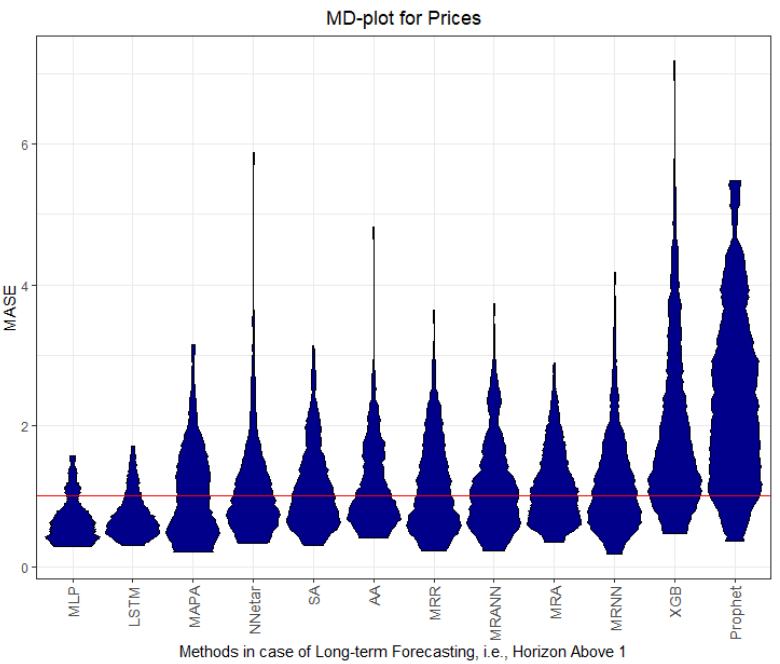
Figure 7. Mirrored density plot of Mean Absolute Scaled Errors (MASE) computed with a rolling forecasting origin over all horizons on dataset